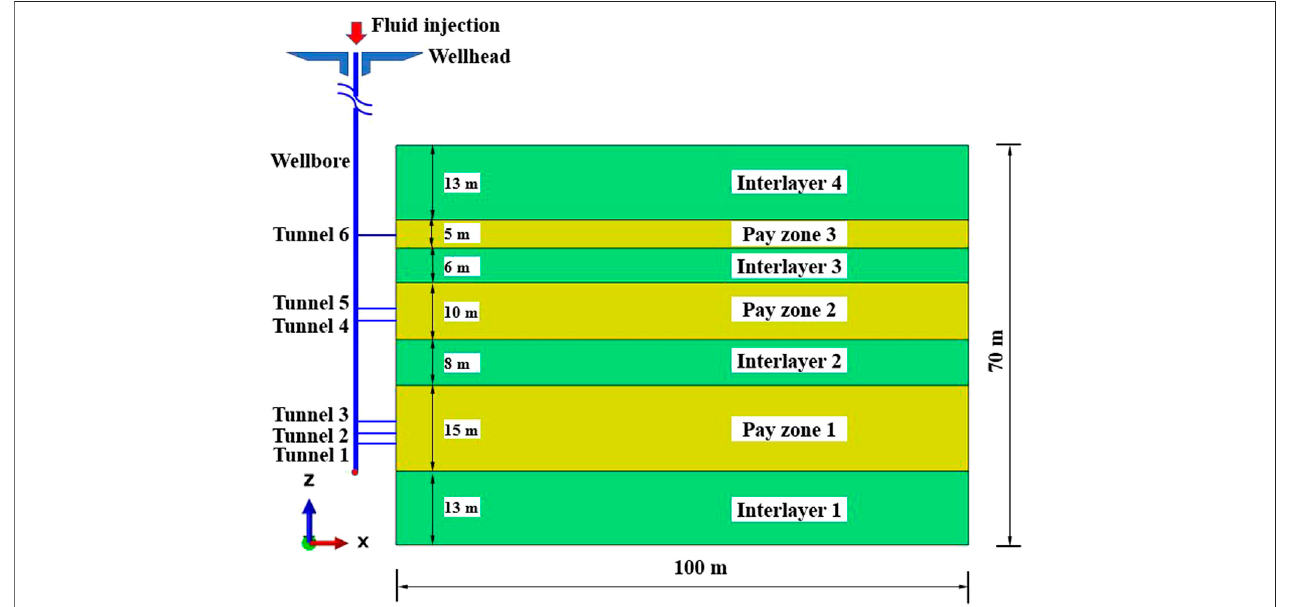
FIGURE 7 | Numerical model containing seven layers, with the integration of fl uid pipe elements.